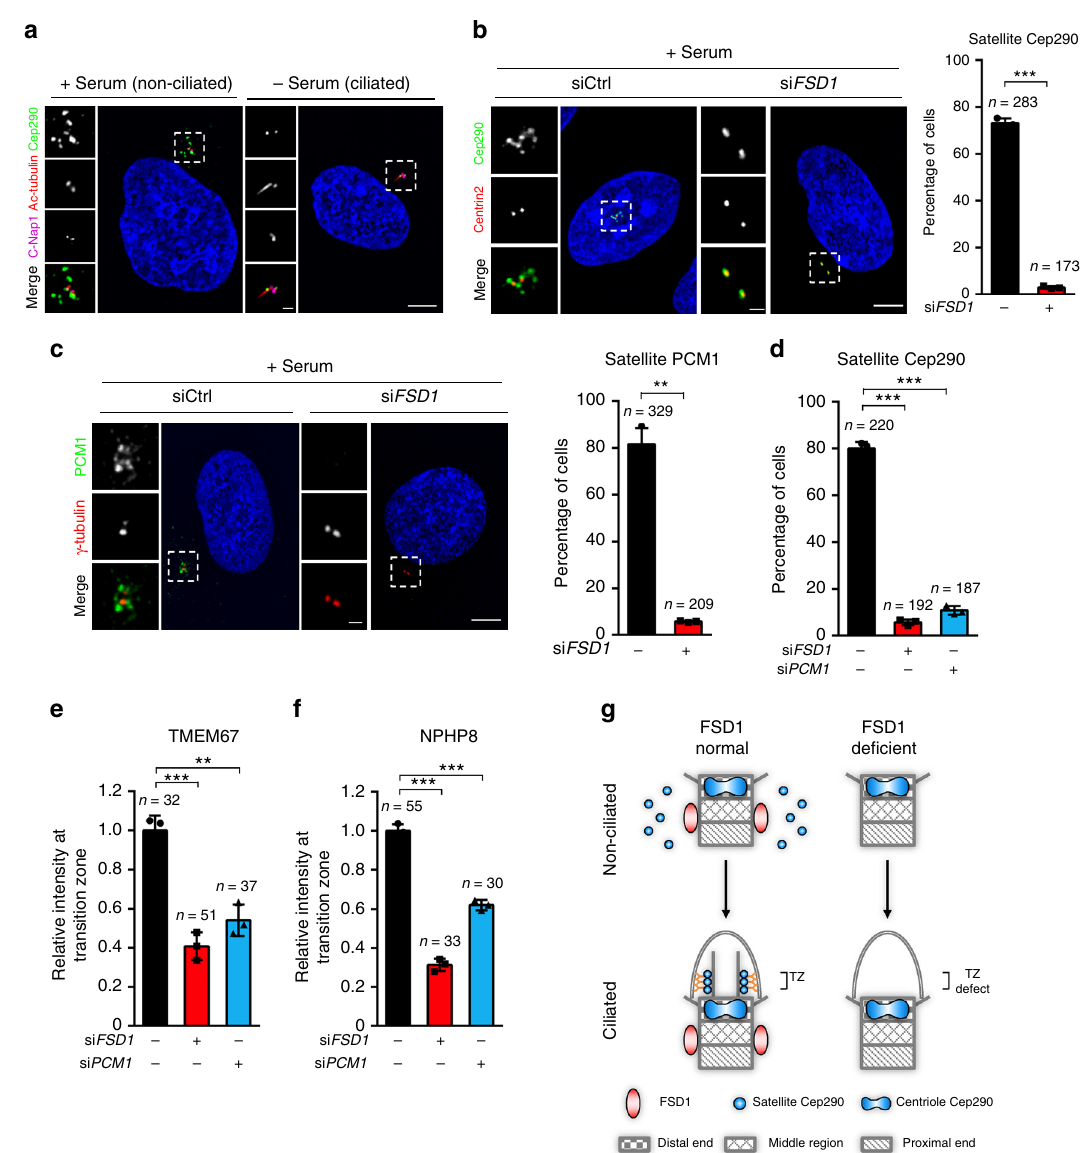
Fig. 4 The maintenance of Cep290 by FSD1 at CS is required for TZ assembly. a Non-ciliated ( + Serum) or ciliated ( − Serum) RPE-1 cells were stained with indicated antibodies as shown. Scale bars, 5 μ m (main image) and 1 μ m (magni fi ed region). b Effects of FSD1 depletion on the localization of Cep290 at centriolar satellites in cycling cells. RPE-1 cells transfected with control or FSD1 siRNAs were stained with anti-Cep290 (green) and anti-Centrin2 (red) antibodies. Scale bars, 5 μ m (main image) and 1 μ m (magni fi ed region). c Effects of FSD1 depletion on the PCM1 localization at centriolar satellites in cycling RPE-1 cells. RPE-1 cells transfected with control or FSD1 siRNAs were stained with indicated antibodies. Scale bars, 5 μ m (main image) and 1 μ m (magni fi ed region). d Effects of FSD1 or PCM1 depletion on the Cep290 localization at centriolar satellites in cycling RPE-1 cells. e , f Effects of FSD1 or